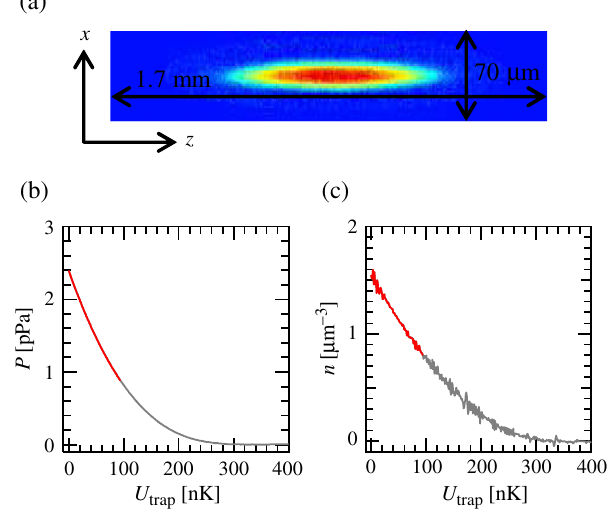
FIG. 2. Typical experimental data at 882.86 G. (a) Absorption image. (b) Local pressure P ð U . (c) Local number density trap Þ n ð U . The red curves in (b) and (c) show the data region used trap Þ in the analysis, where the number density is larger than half of the peak density.